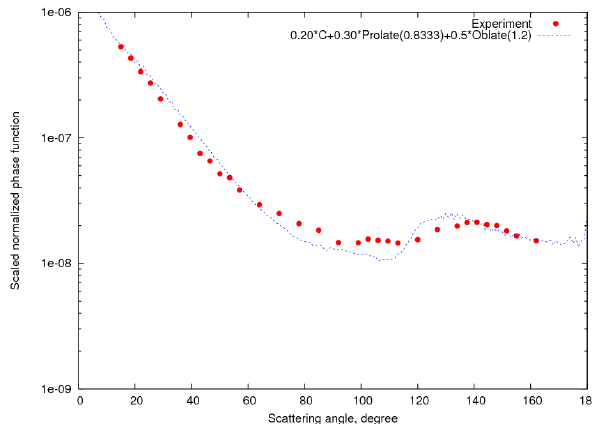
Fig. 7. Same as Fig. 6, but for the weighted habit mixture model 3, 0.2*C+0.3*Prolate(0.8333) + 0.5*Oblate(1.5).